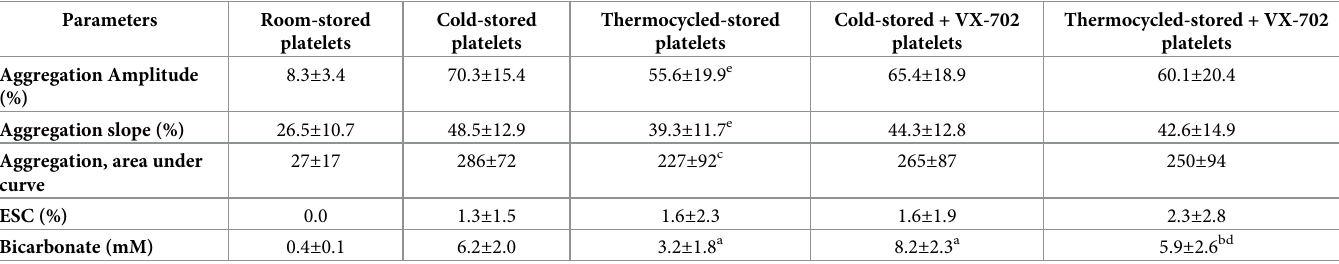
Table 2. Values of platelet parameters on Day 14 of the storage �